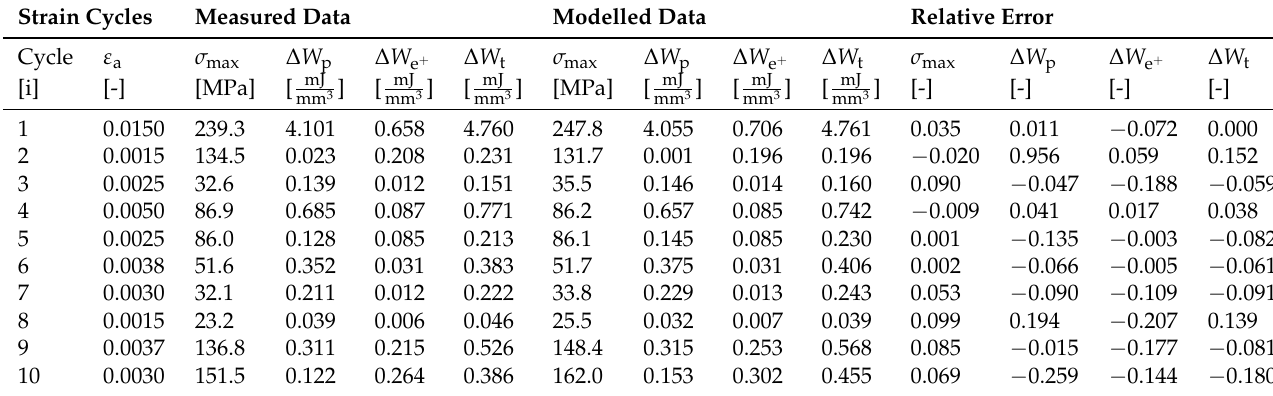
Table 2. Comparison of measured and modelled strain energy densities–variable strain history